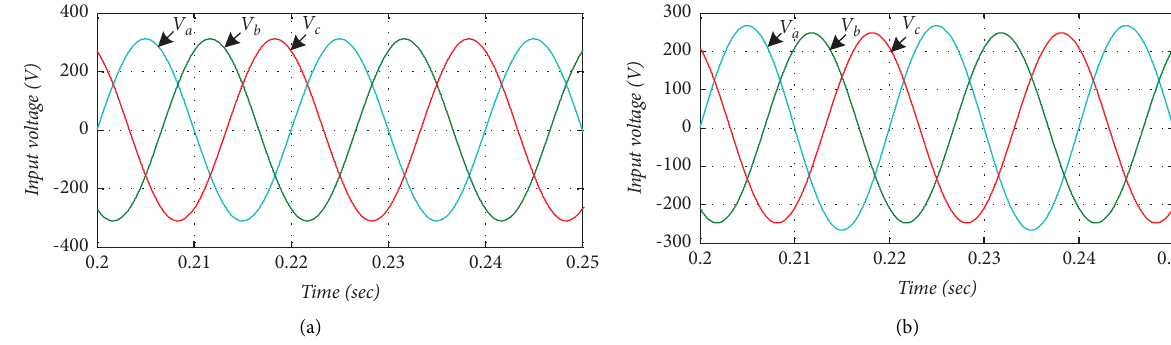
Figure 7: Grid input voltage; (a) balance and (b) unbalance condition with 8% negative sequence component.